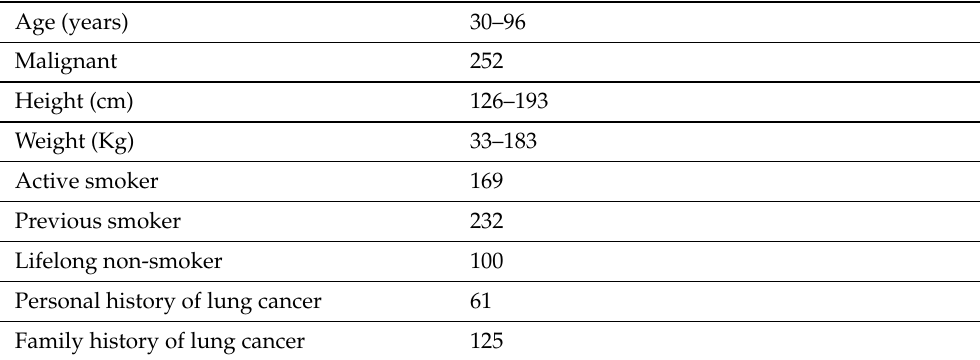
Table 1. Patients clinical